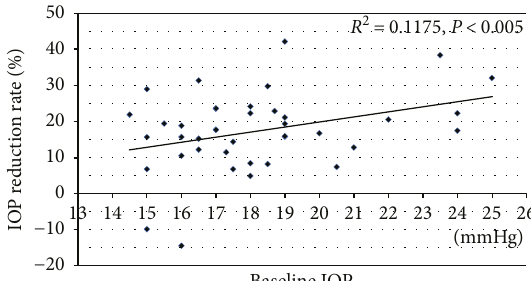
Figure 3: Relationship between baseline IOP and Taf/Tim-induced IOP reduction rate. IOP: intraocular